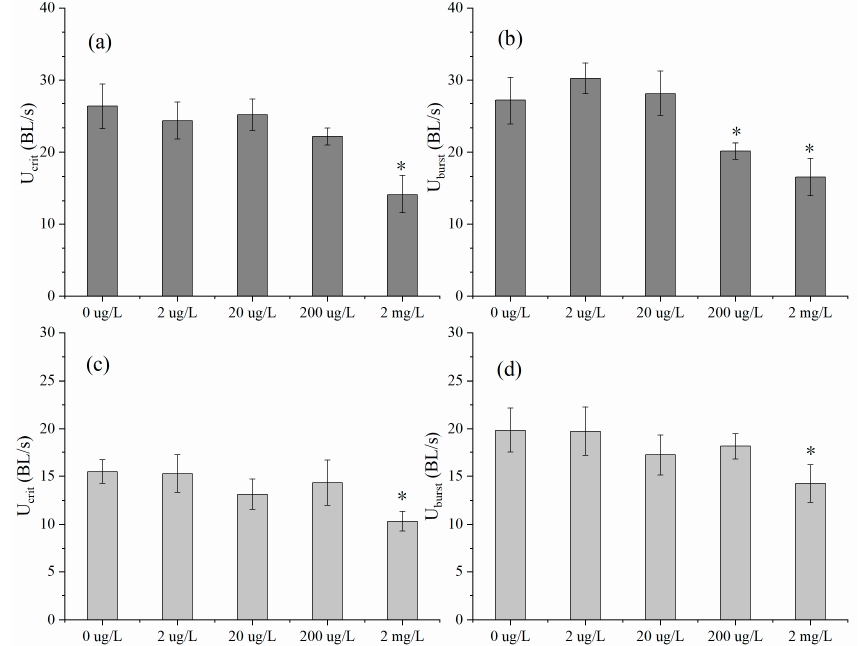
Figure 2. ( a ) Critical swimming speed (U crit ) and ( b ) burst speed (U burst ) of Danio rerio ; ( c ) U crit and ( d ) U burst of Oryzias latipes exposed to varying concentrations (0 µ g / L, 2 µ g / L, 20 µ g / L, 200 µ g / L, and 2 mg / L). Significant di ff erences between the control groups and erythromycin exposed groups, * repersents p < 0.05.